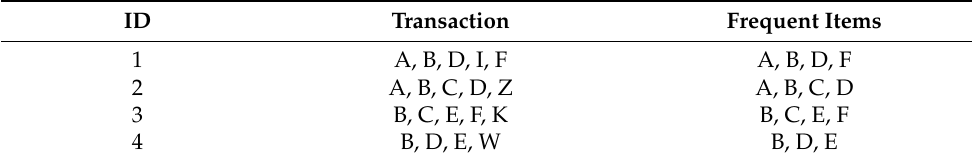
Table 2. The transaction